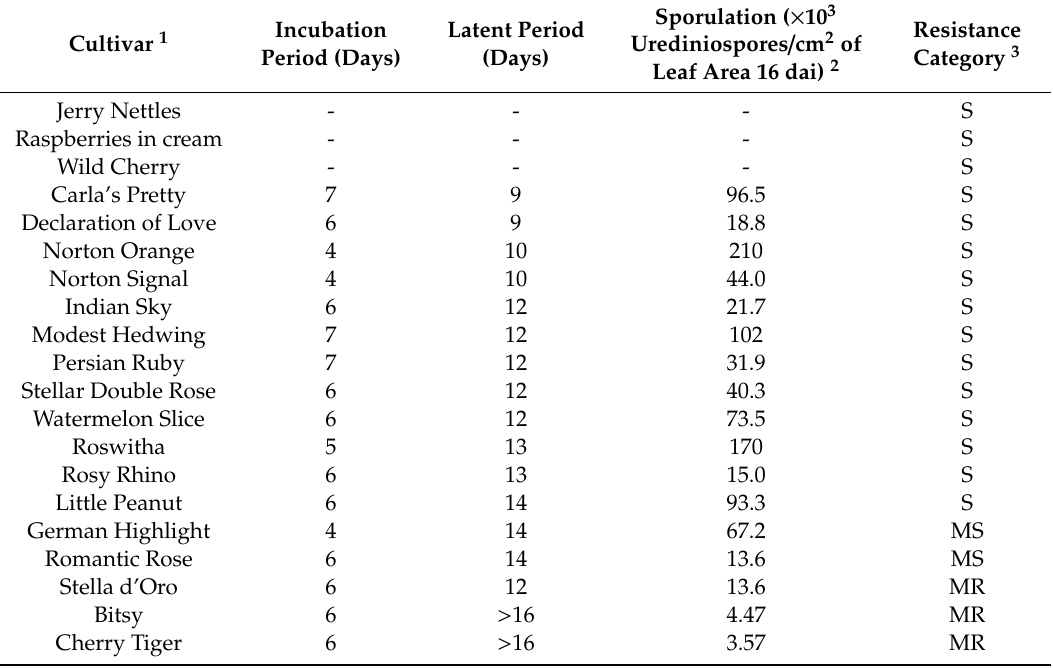
Table 5. Incubation period, latent period, sporulation and resistance category for 17 Hemerocallis cultivars inoculated with Puccinia hemerocallis